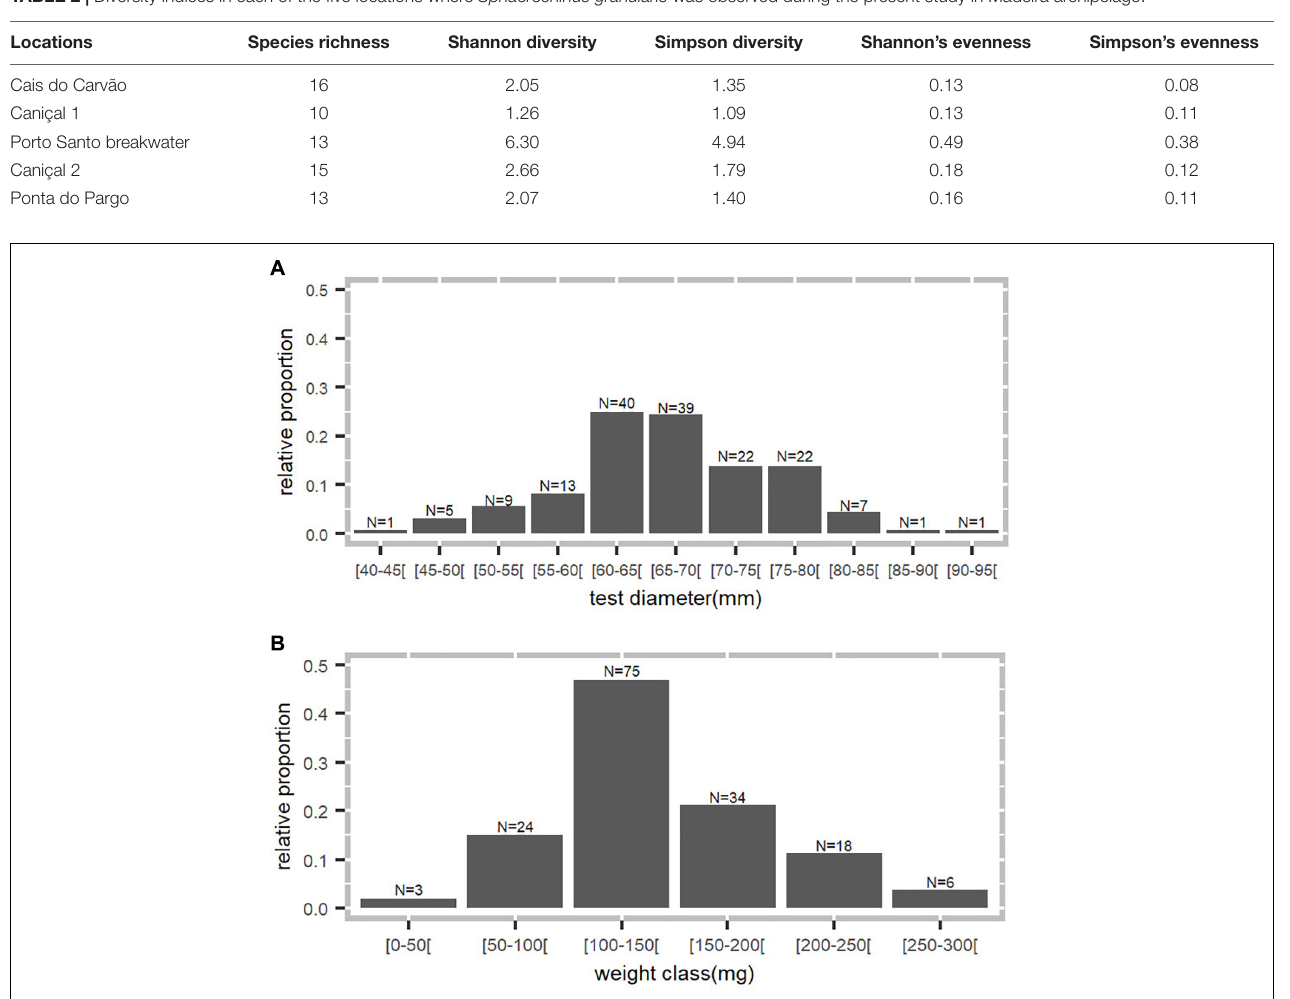
TABLE 2 | Diversity indices in each of the five locations where Sphaerechinus granularis was observed during the present study in Madeira archipelago.